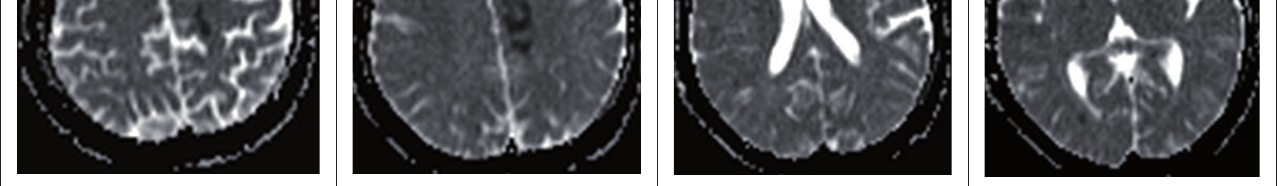
FIGURE 6: Corresponding axial ADC-mapped MR images (a, b, c and d).